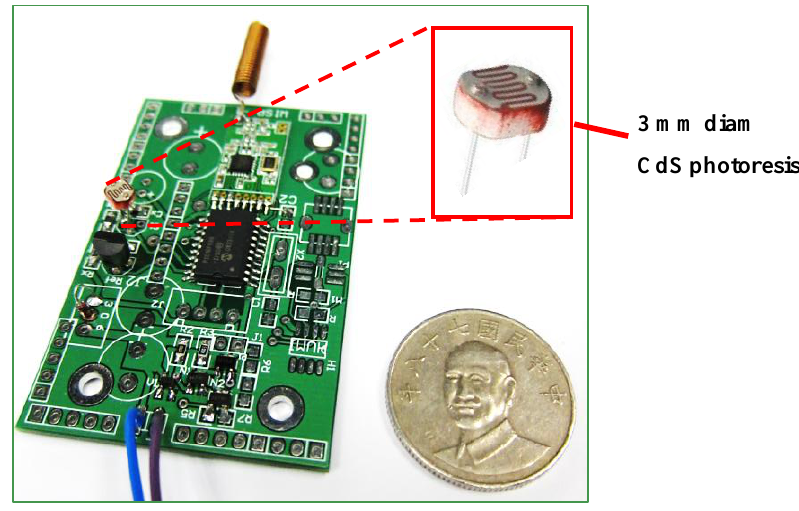
Figure 7. Using a CdS light sensor, the optical sensor module is designed and fabricated as shown in the following photograph.